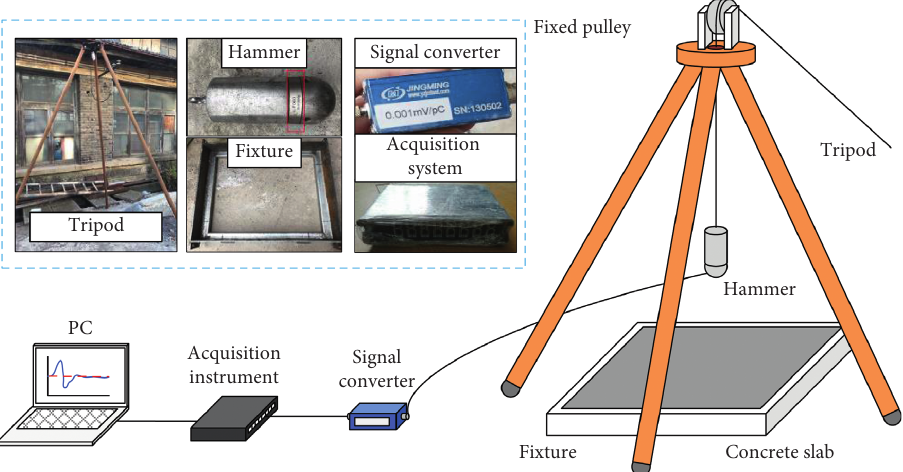
Figure 3: The instrument arrangement of the test system.